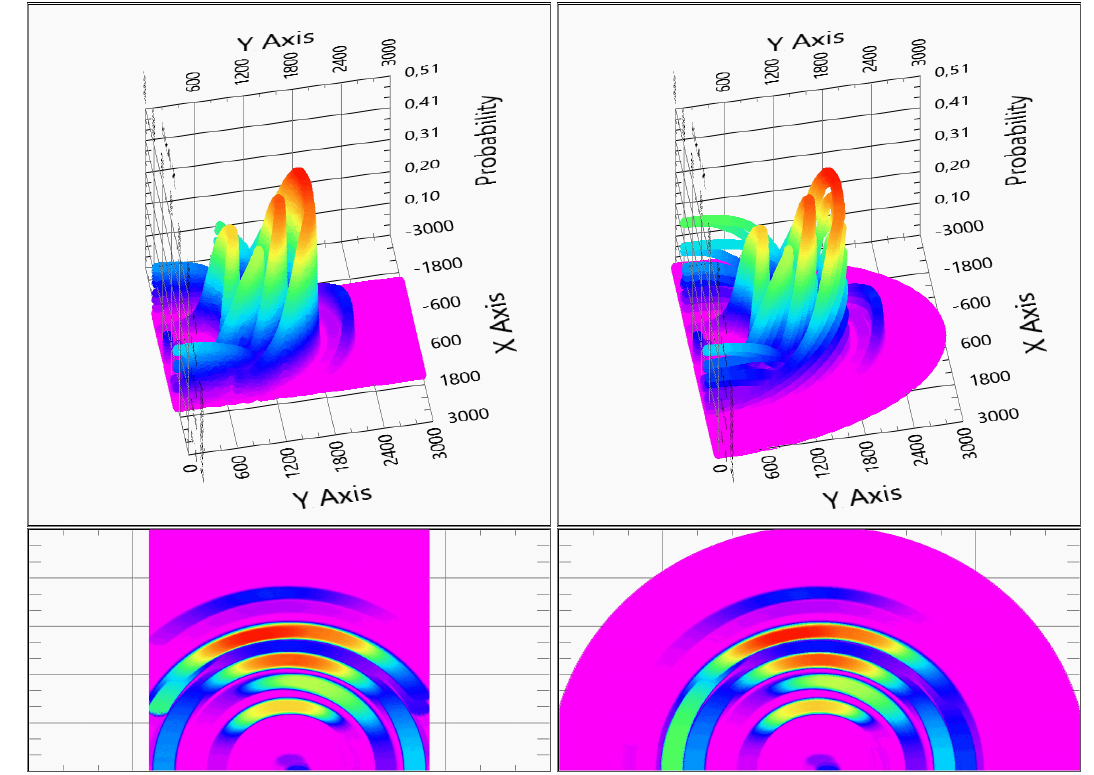
Figure 11. The calculated results in the Cartesian ( left hand side ) and polar ( right hand side ) coordinate raster. In the bottom row, the top views are visible. The three-sensor model system was used.